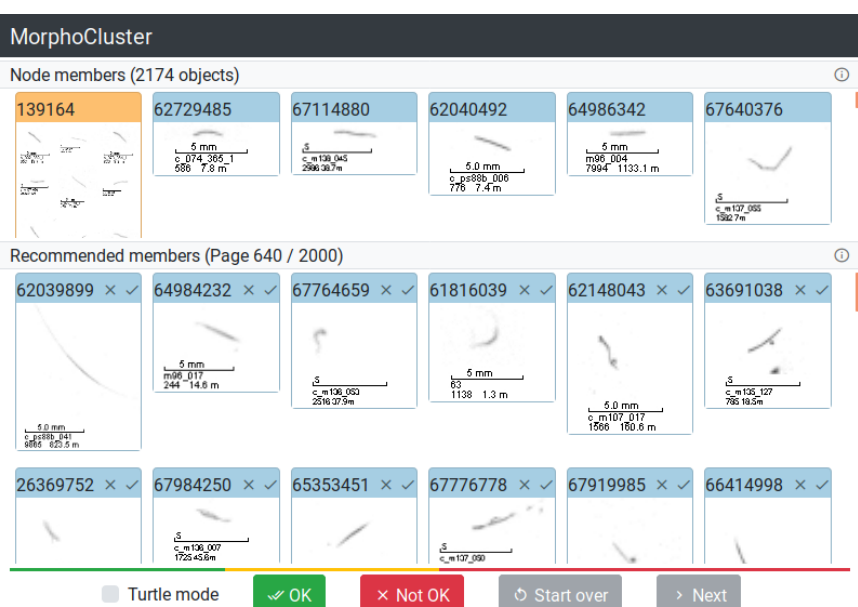
Figure 3. User interface for growing clusters. The top half of the screen displays the current member objects of a cluster. The bottom half always shows a page of 50 candidate members. The colored bar above the buttons visualizes the search interval for the pages of candidates that should be added to the cluster. Pages in green were judged to match the cluster, and pages in red were judged not to match. Pages in yellow were not reviewed